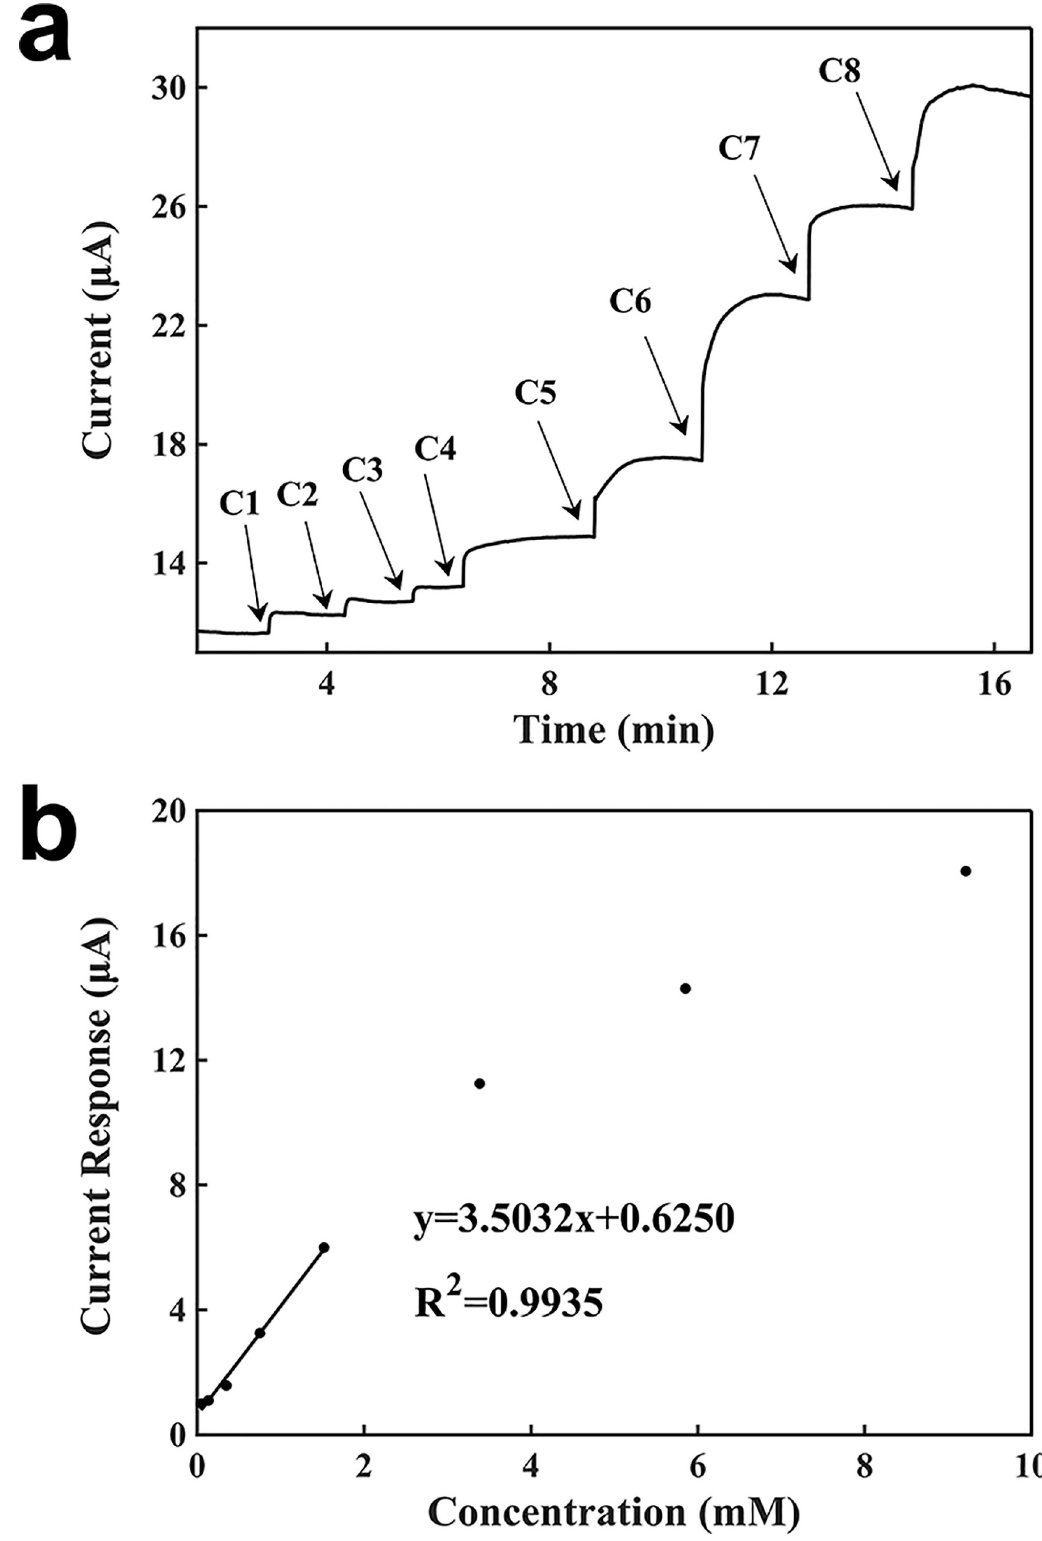
Fig 7. Characterization of the sensor for the detection of lactate using a battery. (a) Current-verses-time response curve upon the additions of lactate. C1: 0.04762 mM, C2: 0.08875 mM, C3: 0.21146 mM, C4: 0.40217 mM, C5: 0.77000 mM, C6: 1.86462 mM, C7: 2.46724 mM, C8: 3.36243 mM. (b) Calibration curve for the detection of lactate.